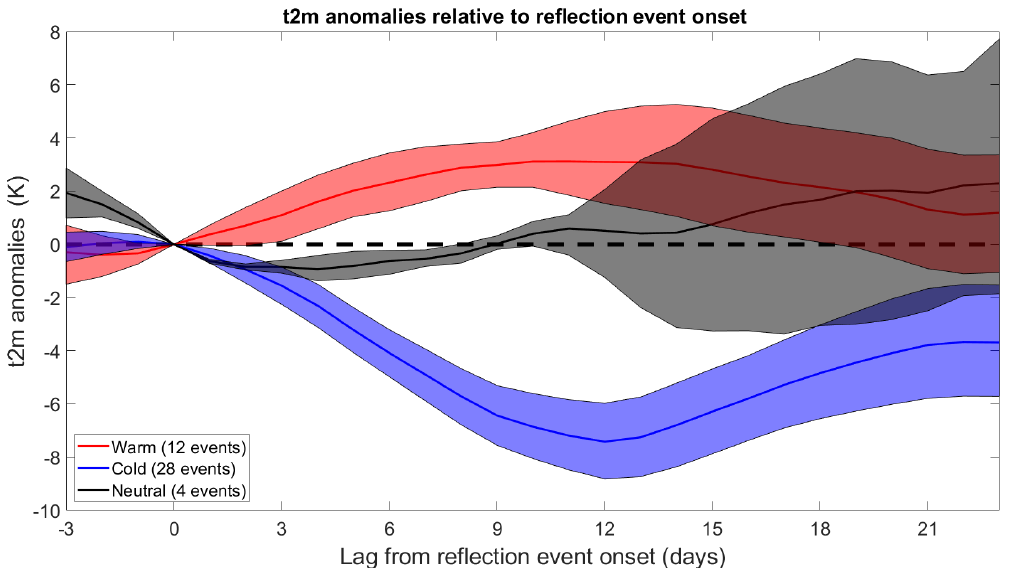
Figure A7. Composite-mean t2m anomalies (K) relative to onset of the reflection events for warm (red), cold (blue) and neutral (black) events. These classes of events are defined according to the area-averaged t2m anomaly over 40–55 ◦ N and 260–290 ◦ E 10d after onset: cold events (28) have an anomaly < − 0.5K; warm events (12) have an anomaly > +0.5K. Events with anomalies between +0.5 and − 0.5K are termed neutral (4). Shading indicates 95% confidence intervals assessed as described in Sect. 2. Due to the small sample size, the confidence interval for neutral events should be interpreted with care.